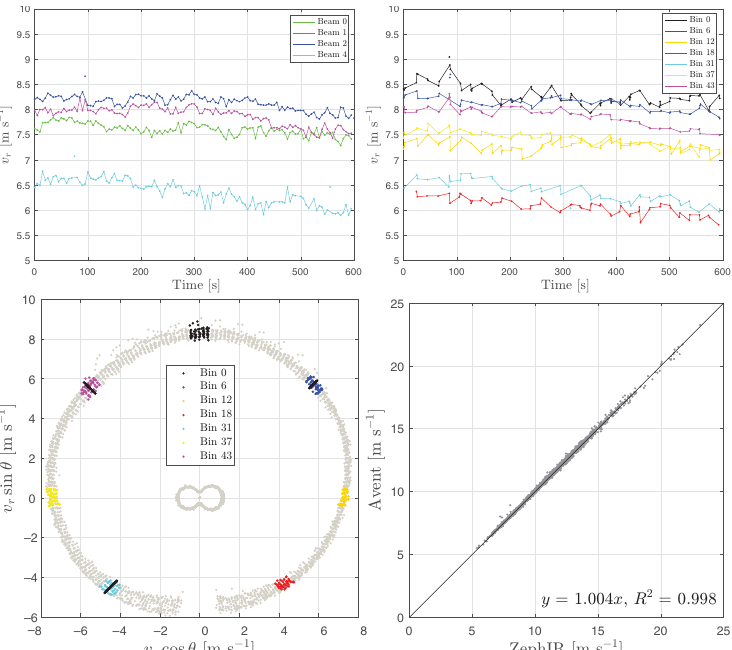
Figure 7. An example of a 10min time series of the radial velocity of different beams for the Avent (top left) and the ZephIR (top right) lidar. The radial velocities of the two lidars at all azimuthal positions are illustrated in the bottom-left panel (see text for details). In the bottom-right panel, we show a comparison of the 2273 10min mean radial velocities of the Avent (beam 2) and ZephIR (bin 6) with the results of a linear regression through the origin and coefficient of determination R 2 . Measurements from beam 3 of the Avent are omitted due to low